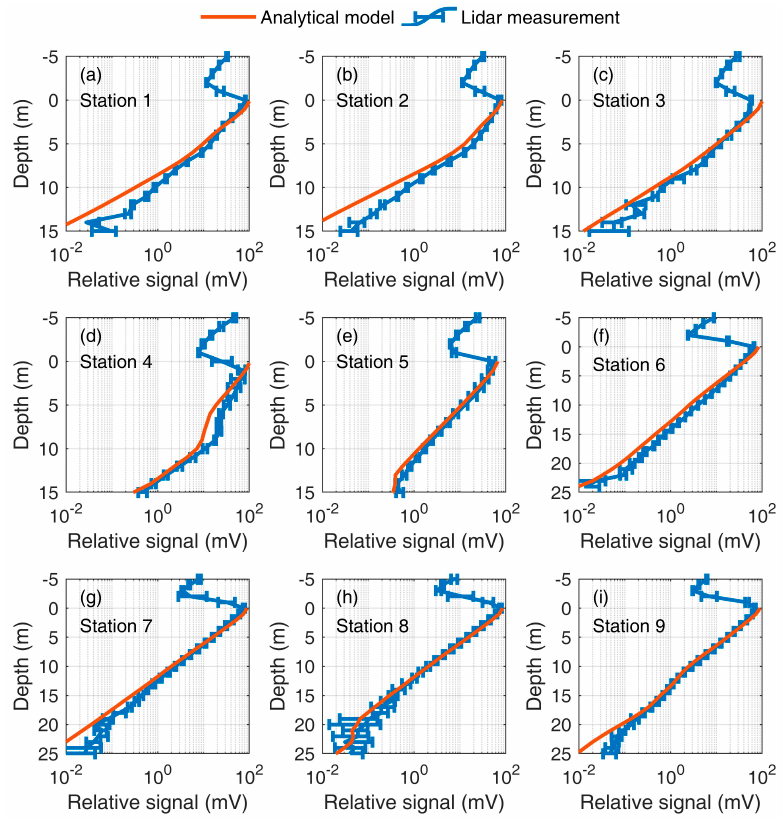
Figure 6. ( a – i ) are the lidar signals calculated by the analytical model (orange solid lines) and measured by the lidar (blue solid lines with error bars) at Stations 1–9, respectively.